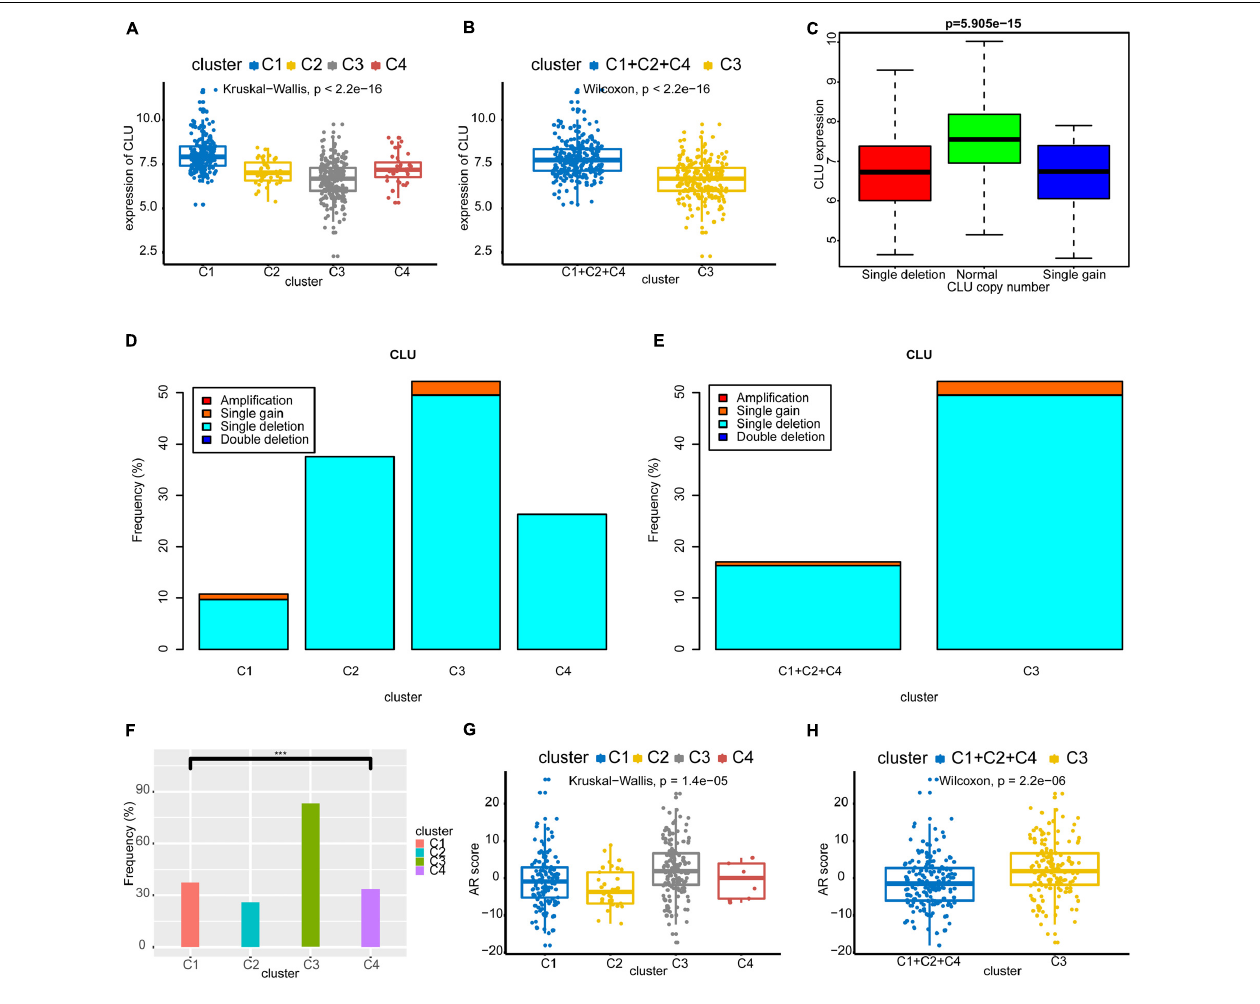
FIGURE 4 | Copy number alterations, TMPRSS2-ERG fusion, and AR scores in each subtype. (A,B) CLU had a lower expression level in C3 subtype. (C) The expression level of CLU was significantly correlated with its CNA, and the expression level of CLU was decreased with single deletion or single gain. (D,E) The frequency of CNA in CLU in C3 subtype was significantly higher than that in other subtypes. (F) C3 had a higher frequency of TMPRSS2-ERG fusion. (G,H) Patients of the C3 subtype had higher AR scores. CAN, copy number alteration; CLU , Clusterin; AR, androgen receptor.